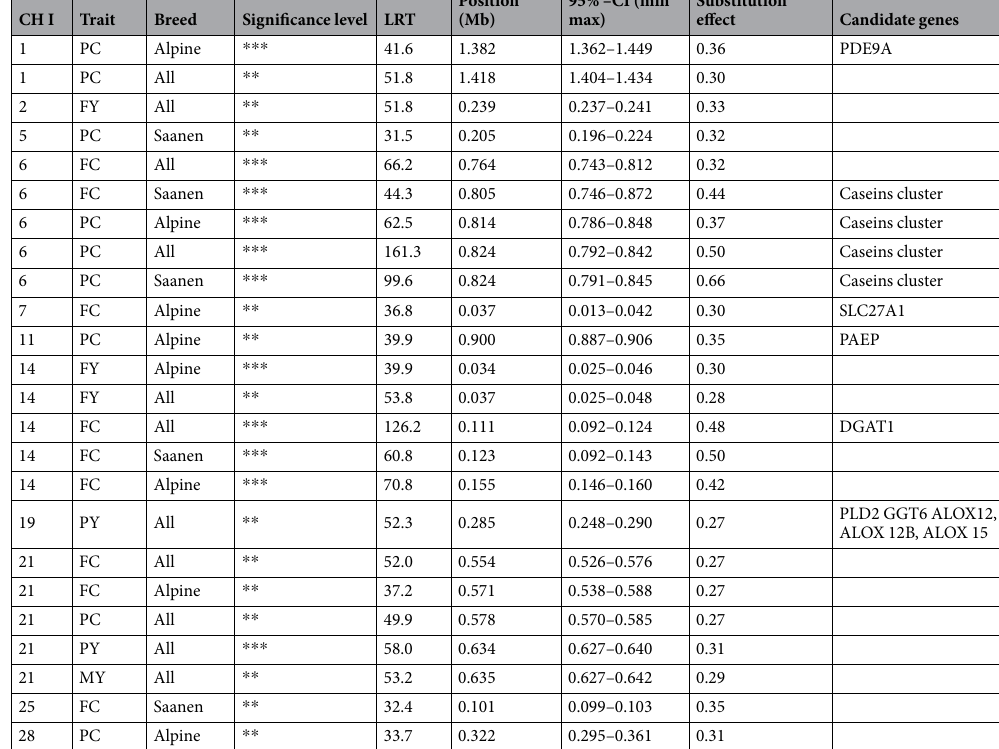
Table 1. Genome scan for milk production traits in a daughter design of 1,941 dairy goats, based on haplotype- based linkage analyses. Significance level: *** : 5% genome-wide; ** 1% chromosome-wide. The 95% confidence intervals of the QTL locations were estimated by logarithm of odds